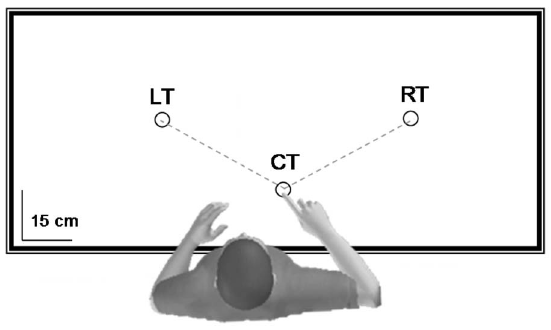
Figure 1. Experimental device (top view). Children, adolescent and young adults performed horizontal arm pointing movements toward two targets placed on the right (60 u , RT) and on the left (60 u , LT) of the central target (CT). The target CT indicated the starting position. Inertial resistance was low in the direction CT-RT and high in the direction CT- LT.